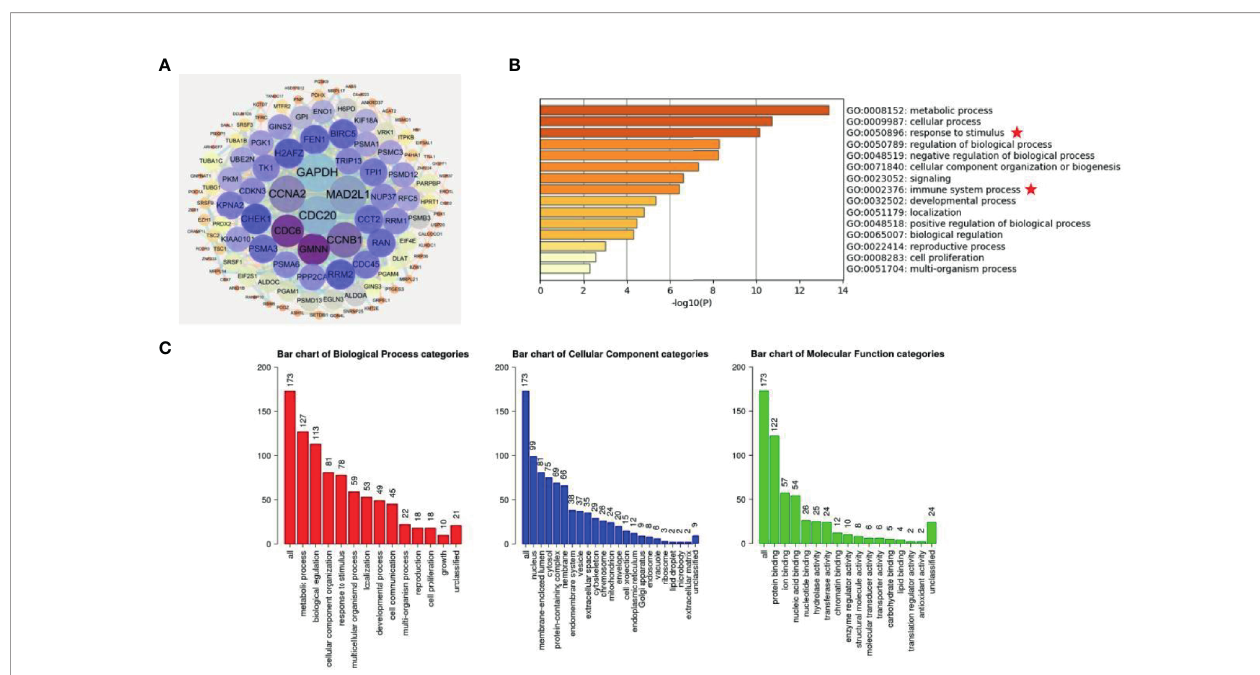
FIGURE 4 | Analysis of the co-expression network and pathway enrichment of LDHA. (A) Using cBioPortal database and Cytoscape software, the PPI network of co-expressed gene with LDHA was constructed. (B) The GO enrichment pathway of LDHA co-expressed genes was analyzed on the Metascape website. (C) The analysis of GO biological processes, molecular functions, and cell components is from the WebGestalt website.